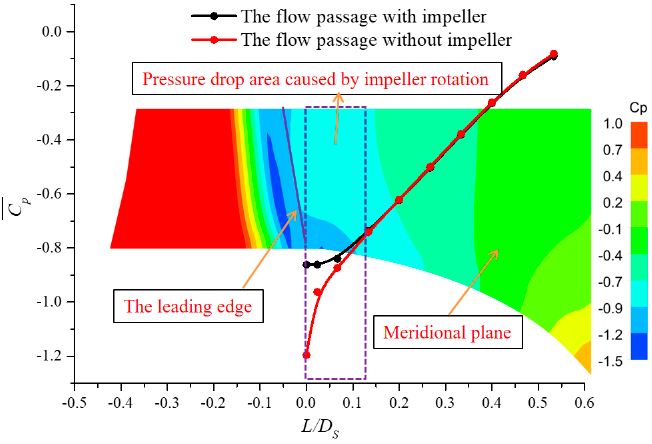
Figure 14. Distribution of